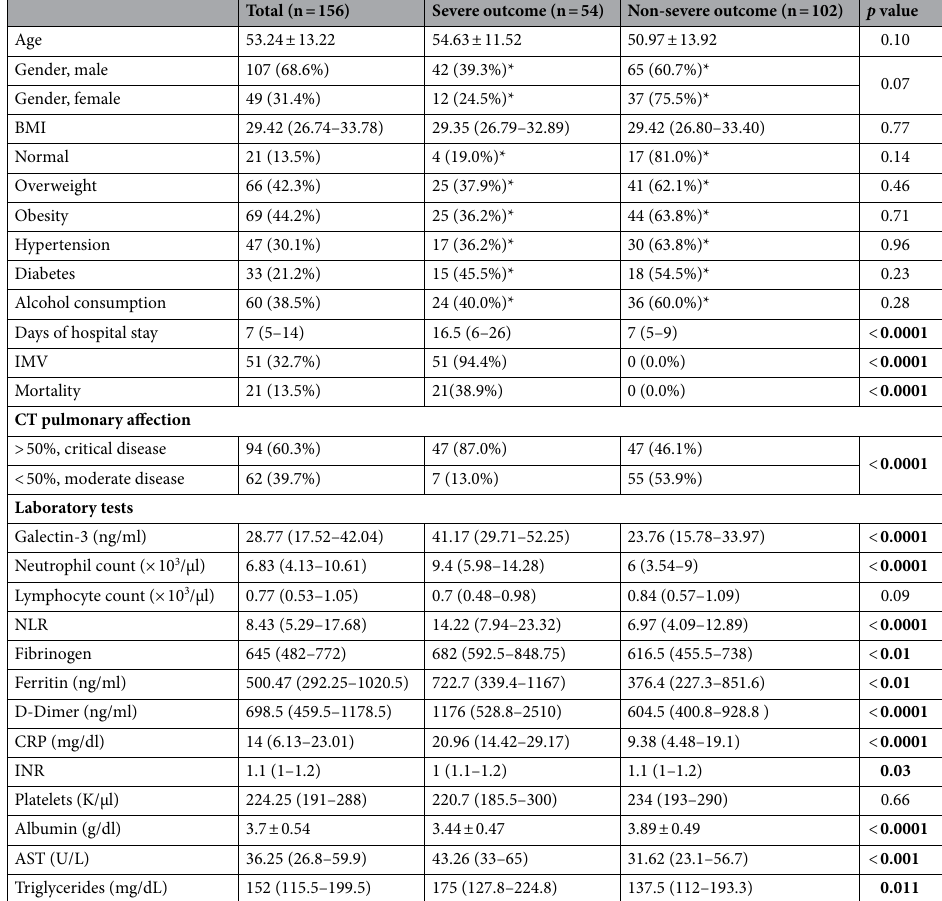
Table 1. Demographic, clinical and laboratory characteristics. Data are reported as median (IQR), mean (± SD) and n (%).Comparisons were performed with Pearson’s Chi-squared test or Fisher’s exact test and